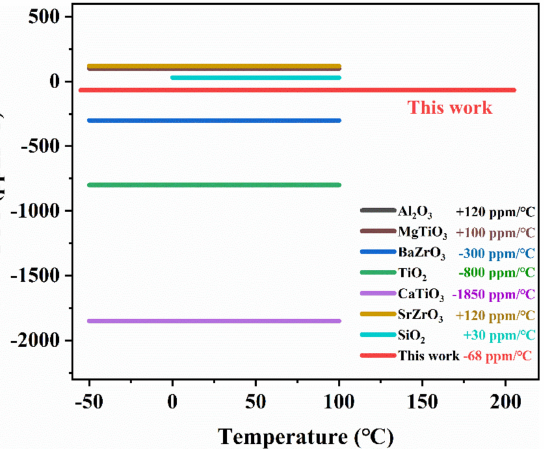
Figure 5. A TCC value comparison of this work and other reported linear dielectrics. Data are from references